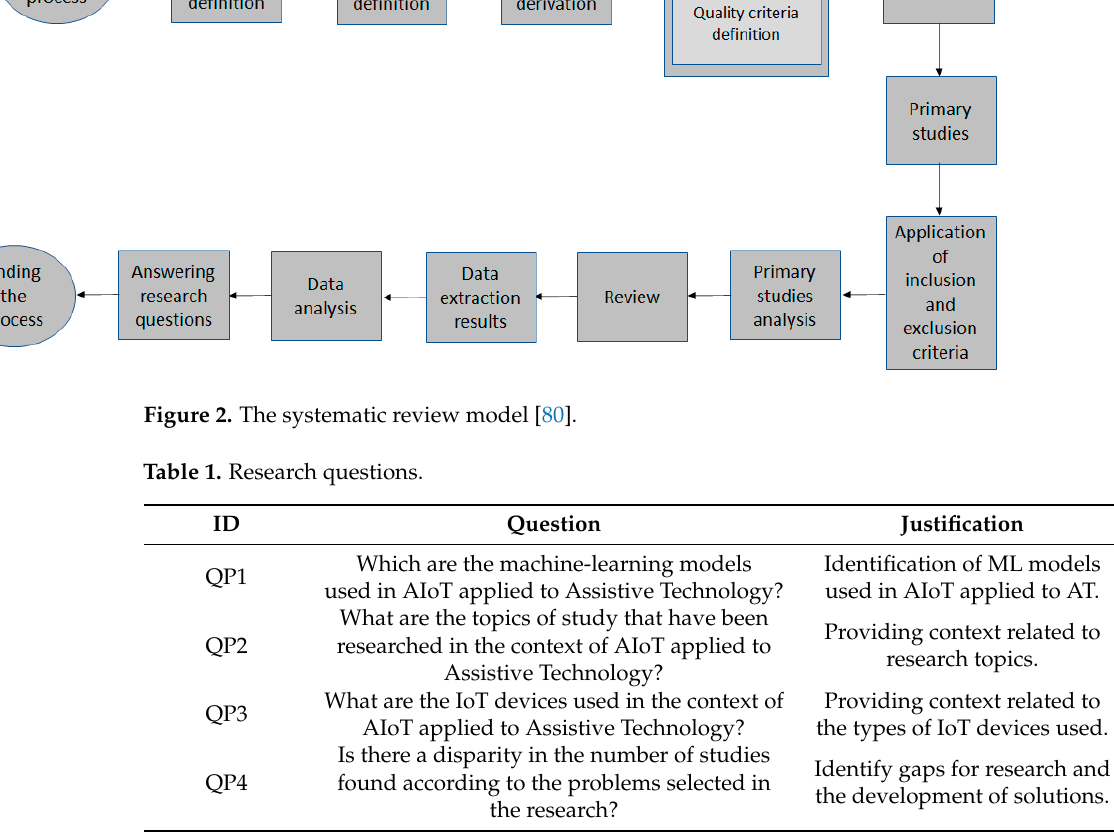
Table 1. Research questions.